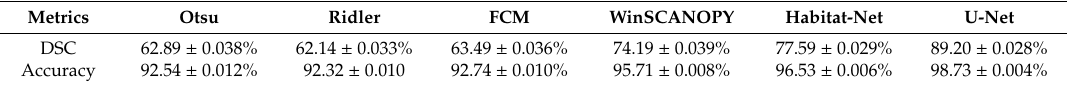
Table 1. Results for the six segmentation methods. DSC: Dice similarity coe ffi